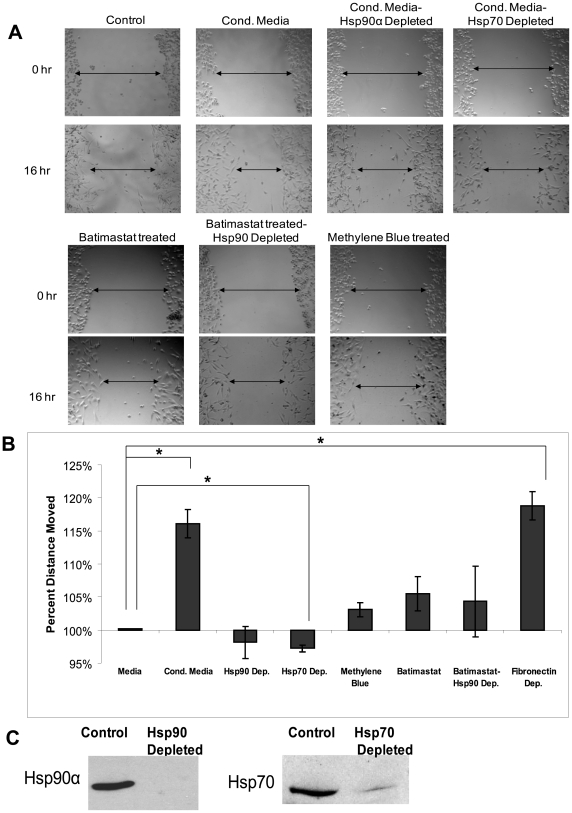
Hsp90α and its co-chaperone complex assist in wound healing.MDA-MB-231-s4175 cells were plated in an 8-well chamber slide and allowed to grow to confluency. A wound was created in the monolayer and either media, untreated conditioned media, Hsp90α depleted conditioned media, Hsp70 depleted conditioned media, 40 nM Batimastat (an MMP inhibitor) treated conditioned media, or 30 µM Methylene Blue (an Hsp70 inhibitor) treated conditioned media were added to the cells. The cells were incubated for 16 hours, and then wound closure was observed. (a) Representative pictures of wounded cells at 0 hours and 16 hours. (b) Graph of relative movement of cells. (c) SDS-PAGE showing Hsp90α and Hsp70 depletion. Experiment was repeated three times. (*P-value<0.01).